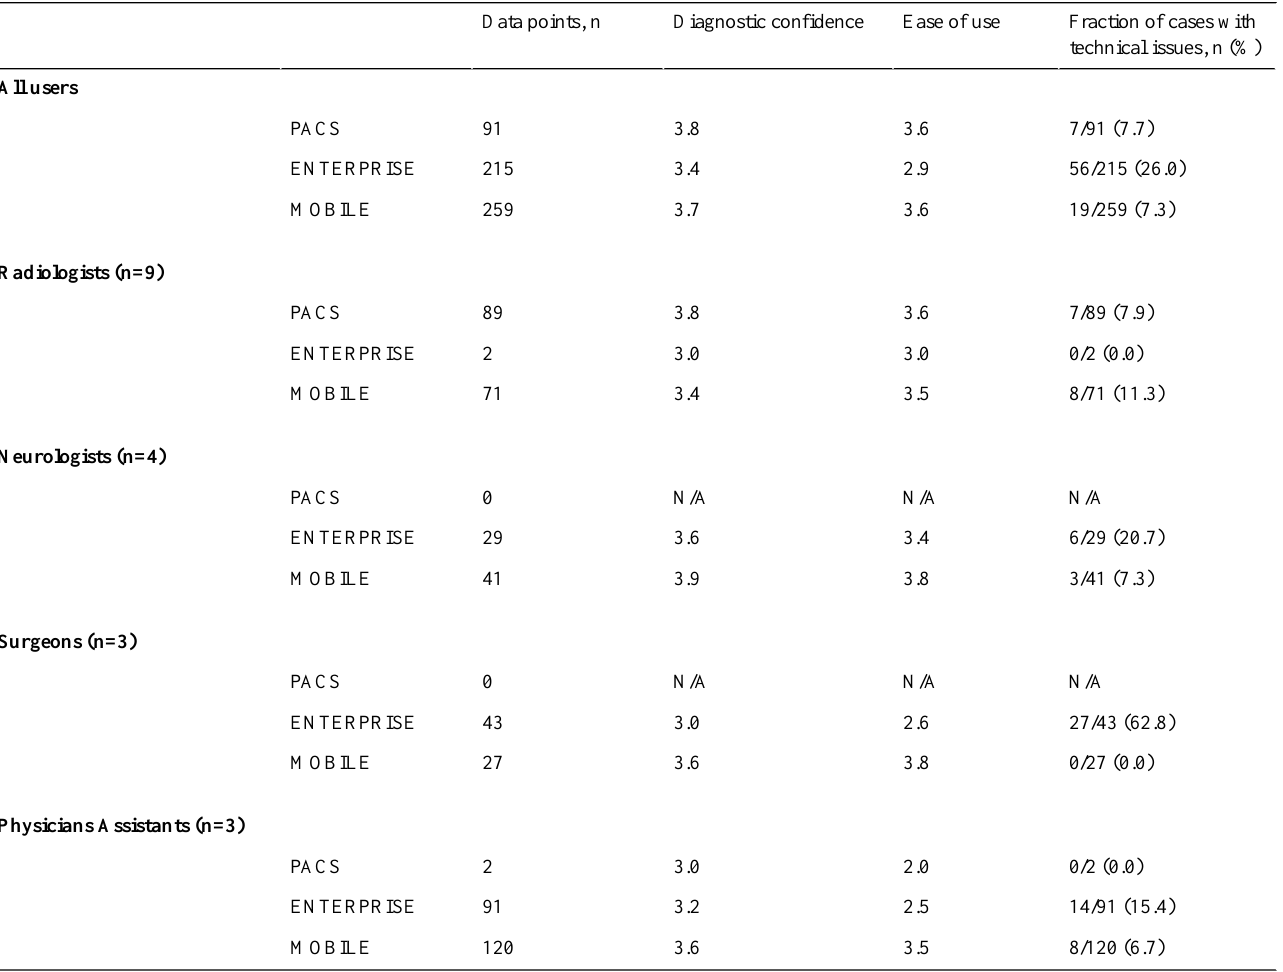
Table 1. Mobile radiology image viewers compared with conventional desktop viewers: qualitative results by user group.